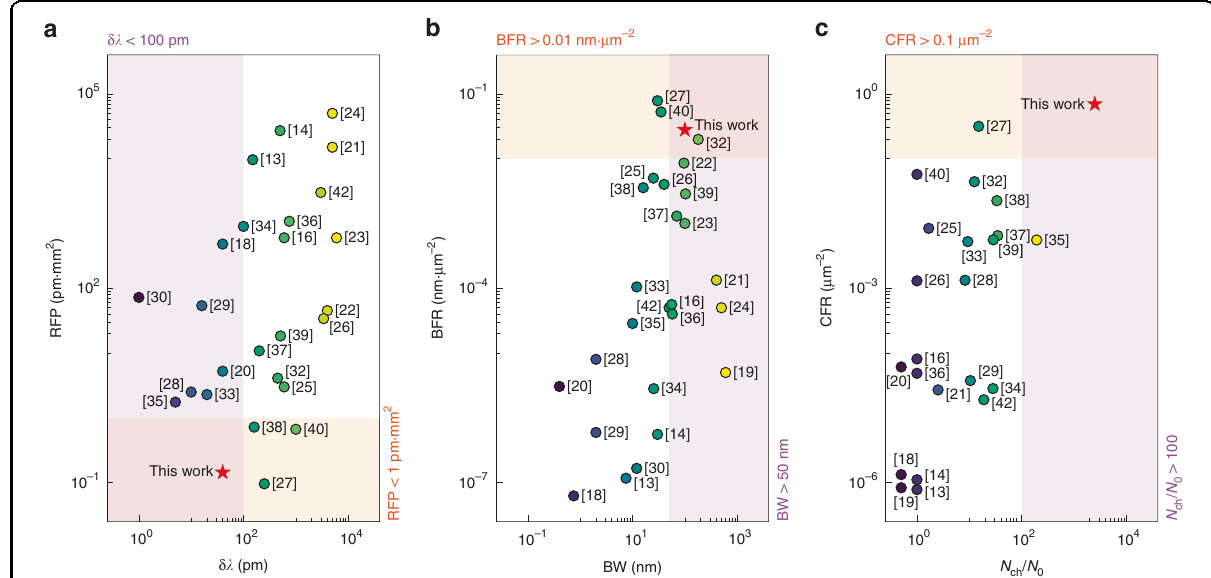
Fig. 8 Comparison of reported spectrometers. The performance is compared with the focus on a resolution-footprint products (RFP) versus resolutions ( δλ ), b bandwidth-to-footprint ratios (BFR) versus bandwidths (BW), and c channel-to-footprint ratios (CFR) versus spectral-to-spatial